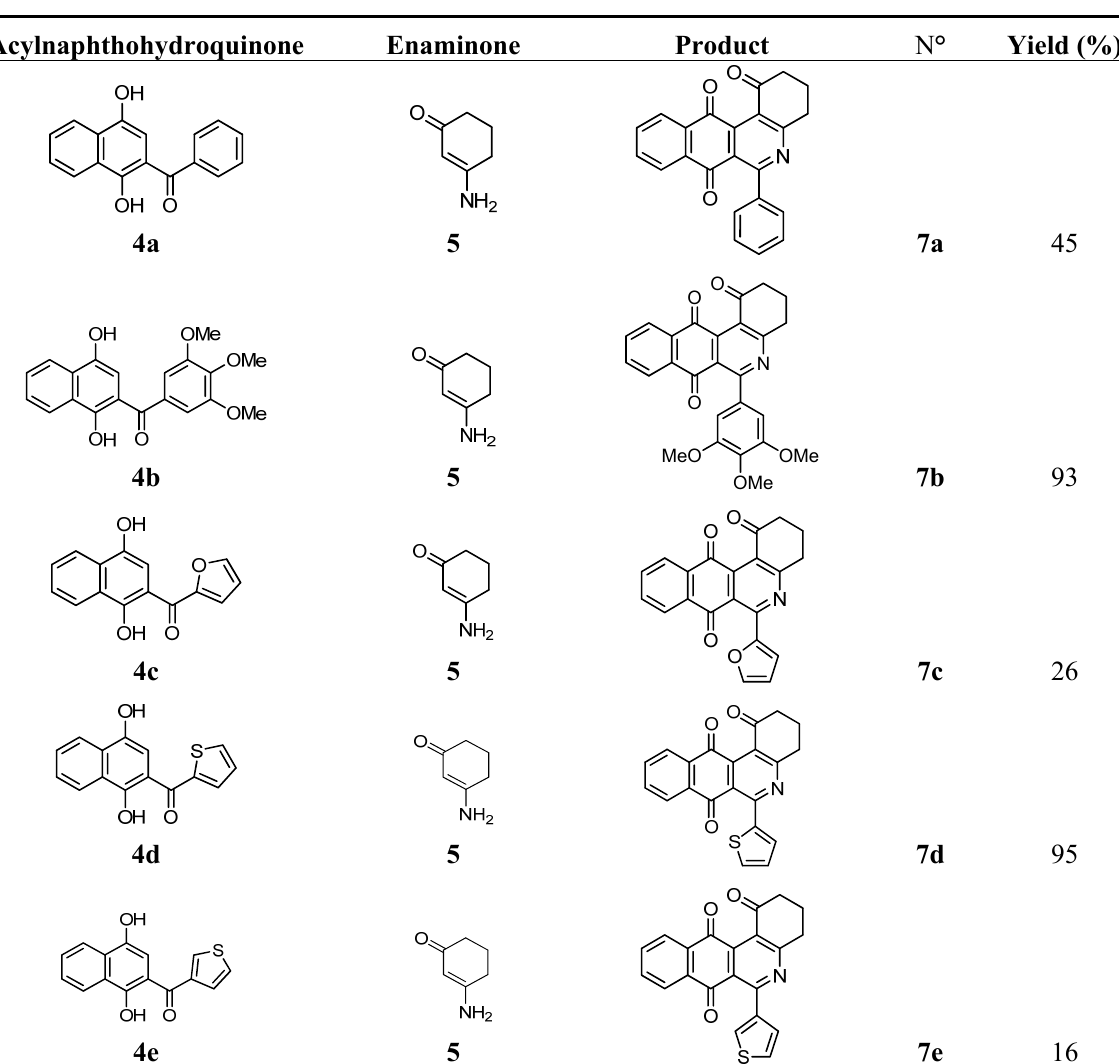
1. Preparation of benzo[ j ]phenanthridine-